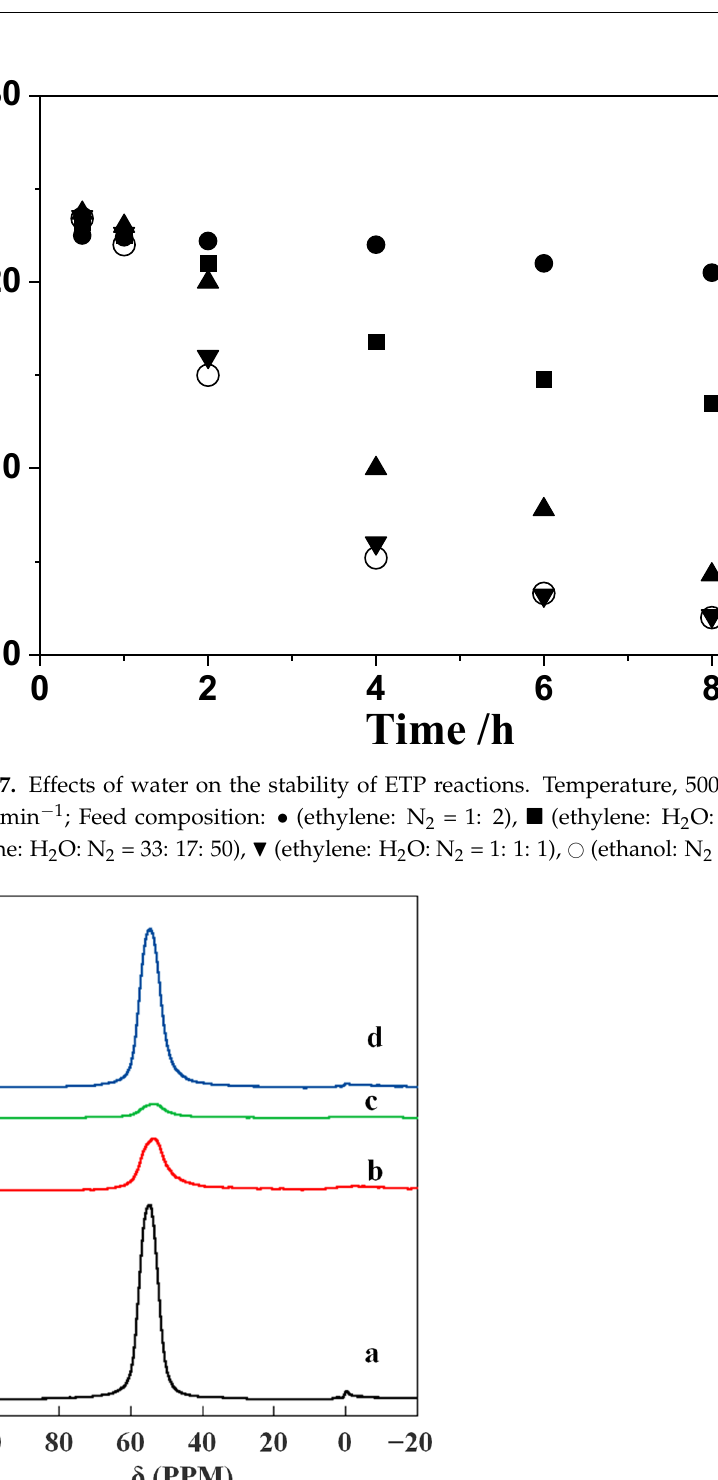
Figure 8. 27 Al MAS NMR spectra of fresh and post-reaction (8 h reaction) H-ZSM-5(80) catalysts. Feed composition: ( a ) fresh catalyst, ( b ) ethanol reaction (ethanol: N 2 = 1:1), ( c ) ethylene and water reaction (ethylene: water: N 2 = 1:1:1), ( d ) ethylene reaction (Ethylene: N 2 = 1:2).